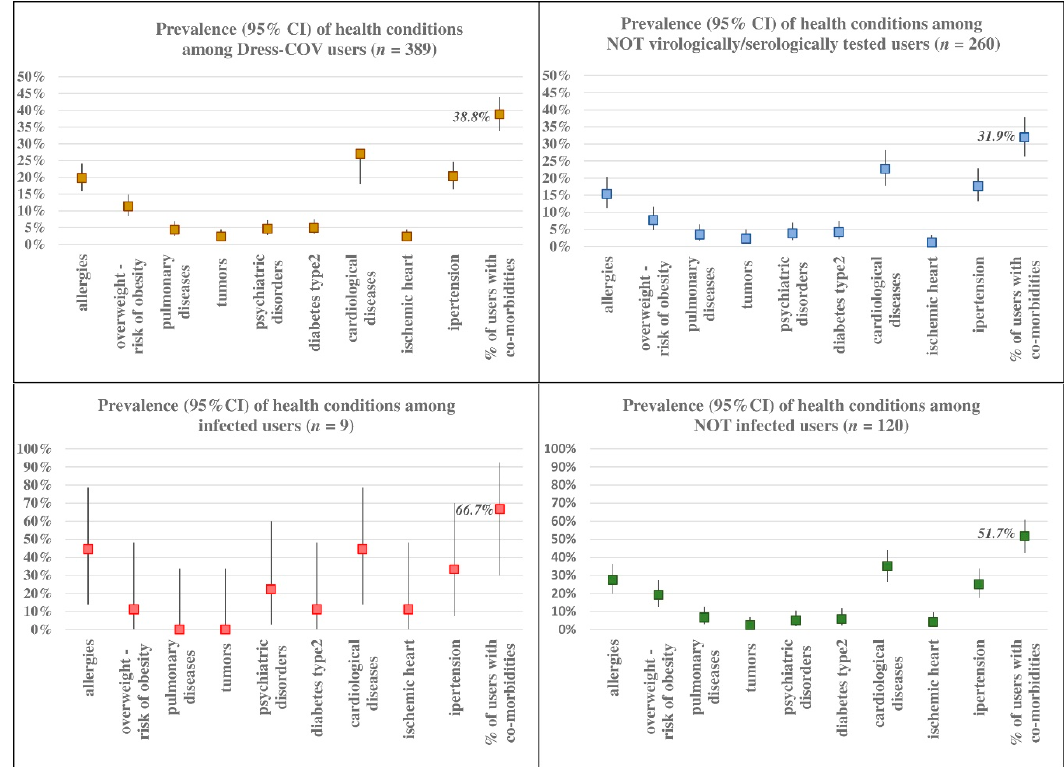
Figure 8. Dress-COV: co-morbidity rates. Int. J. Environ. Res. Public Health 2020 , 17 , x